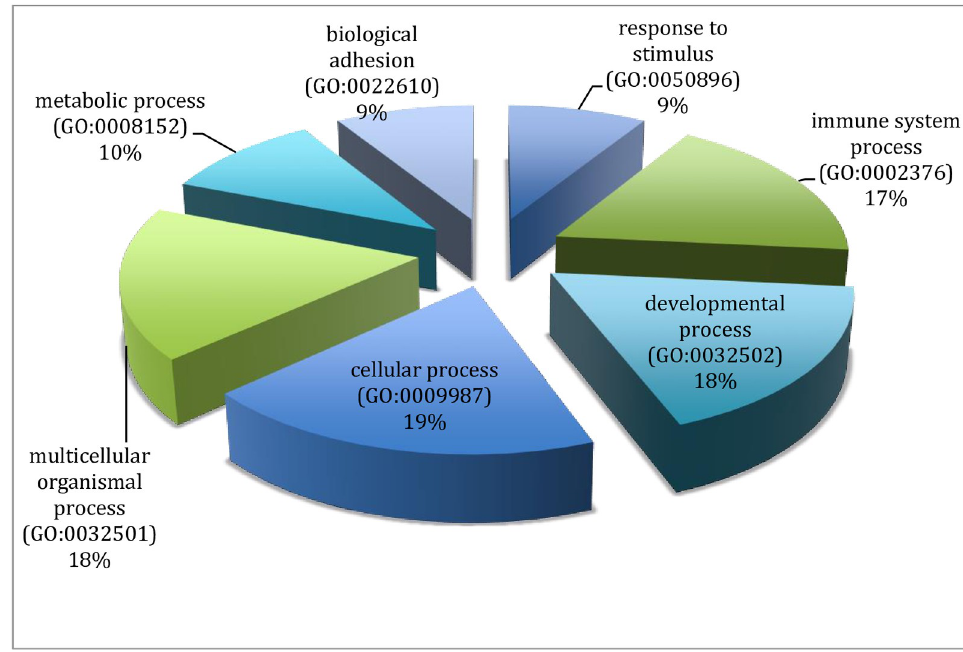
Fig 8. Gene ontology of the downregulated genes, showing their biological functions.